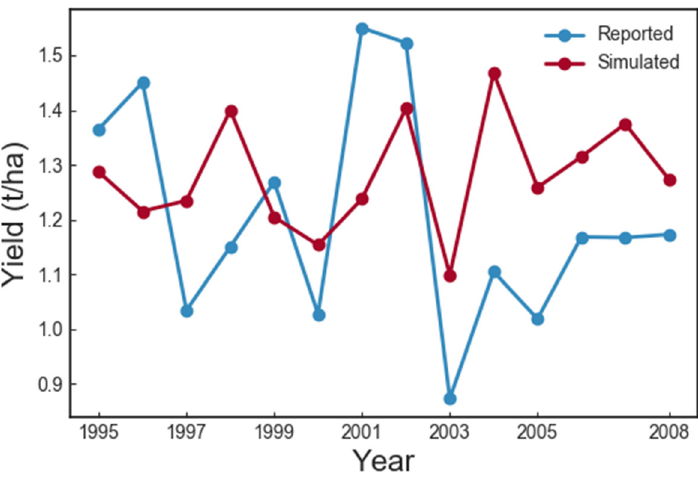
Figure 1. Simulated and reported national maize yields in Tanzania.